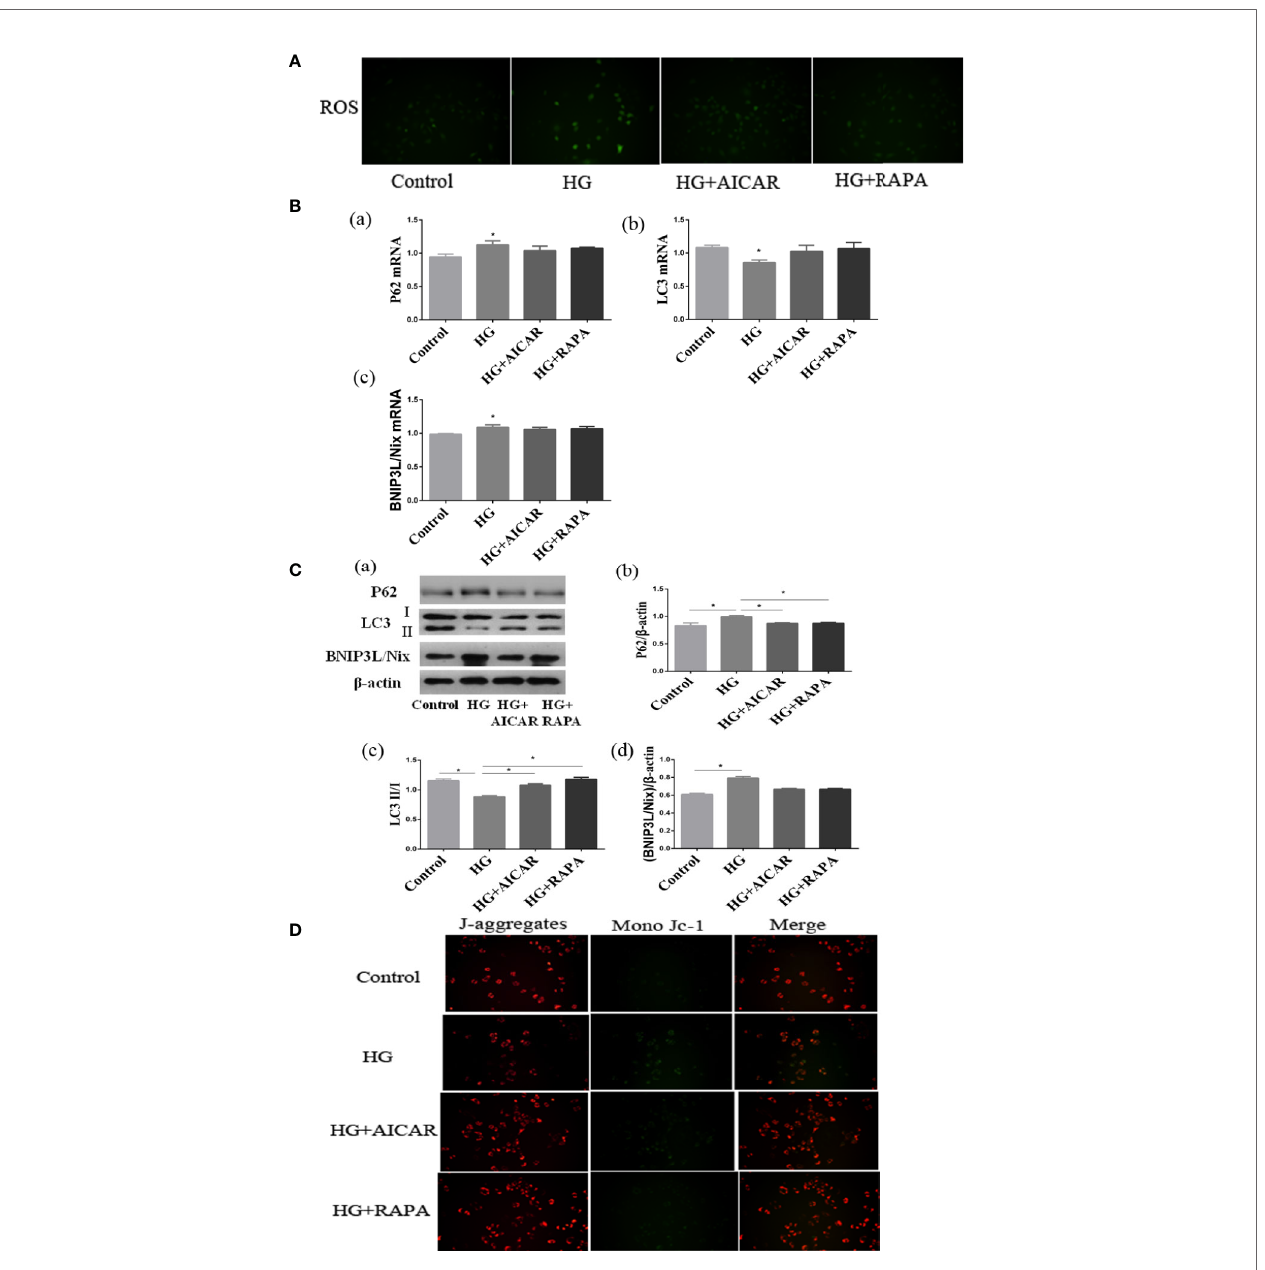
FIGURE 7 | Damages could be reversed by AMPK activation or mTOR inhibition. (A) ROS changes in NRK-52E cells (200*). (B, C) AMPK/mTOR signaling pathway of mitophagy in NRK-52E cells in acute hyperglycemia group (16.7 mmol/L). (D) Mitochondrial membrane potential changes in NRK-52E cells (200*). Values are expressed as means ± SD in each group. * P < 0.05 vs. Control. Control, control group; HG, hyperglycemia group. AMPK, 5 ’ -AMP-activated protein kinase; mTOR, mammalian target of rapamycin complex. AICAR, 5-Aminoimidazole-4-carboxamide1- b -D-ribofuranoside; RAPA,